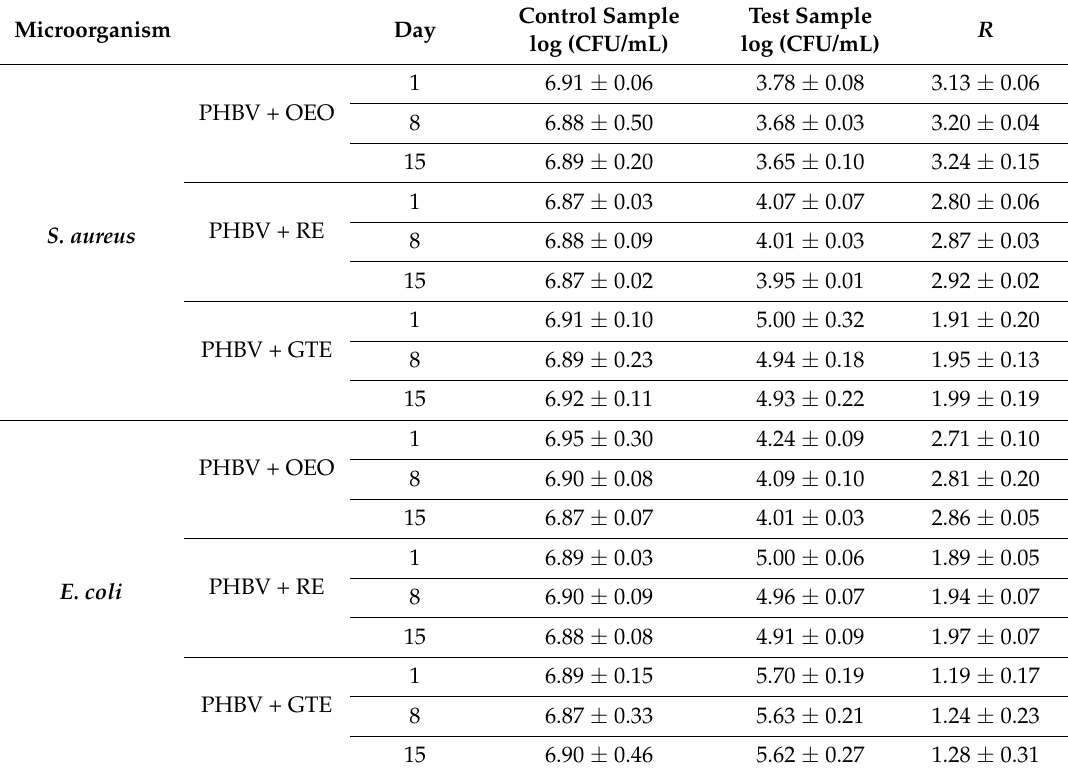
Table 5. Antibacterial activity against S. aureus and E. coli of the electrospun poly(3-hydroxybutyrate- co -3-hydroxyvalerate) (PHBV) films containing oregano essential oil (OEO), rosemary extract (RE), and green tea tree extract (GTE) in the open system for up to 15